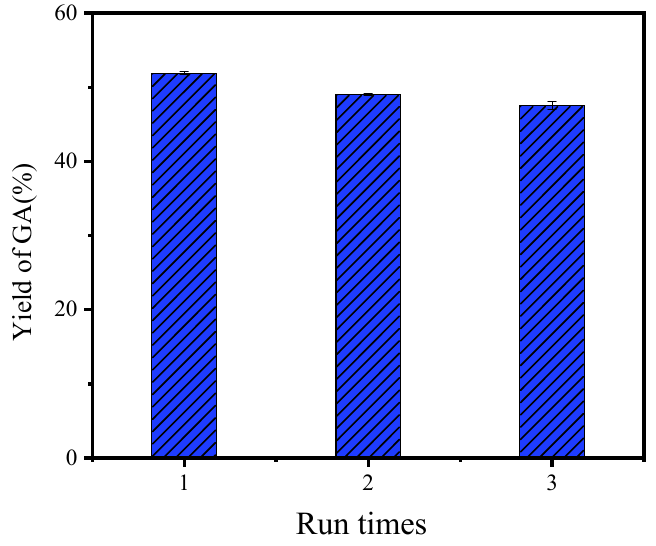
Figure 14. The reusability of Bi/ β -2 catalyst for production from cellulose. Reaction conditions: cel-